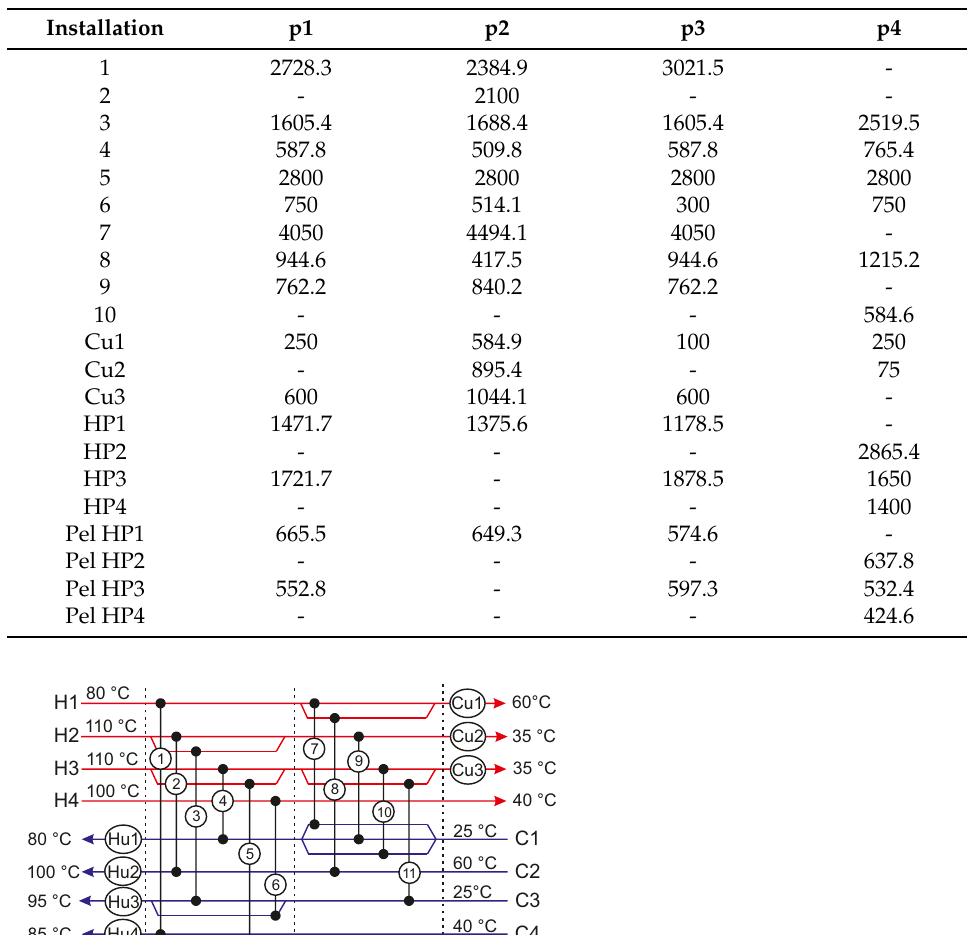
Table 10. Heat Flows and P el results with HP and ST options case 3 (kW).